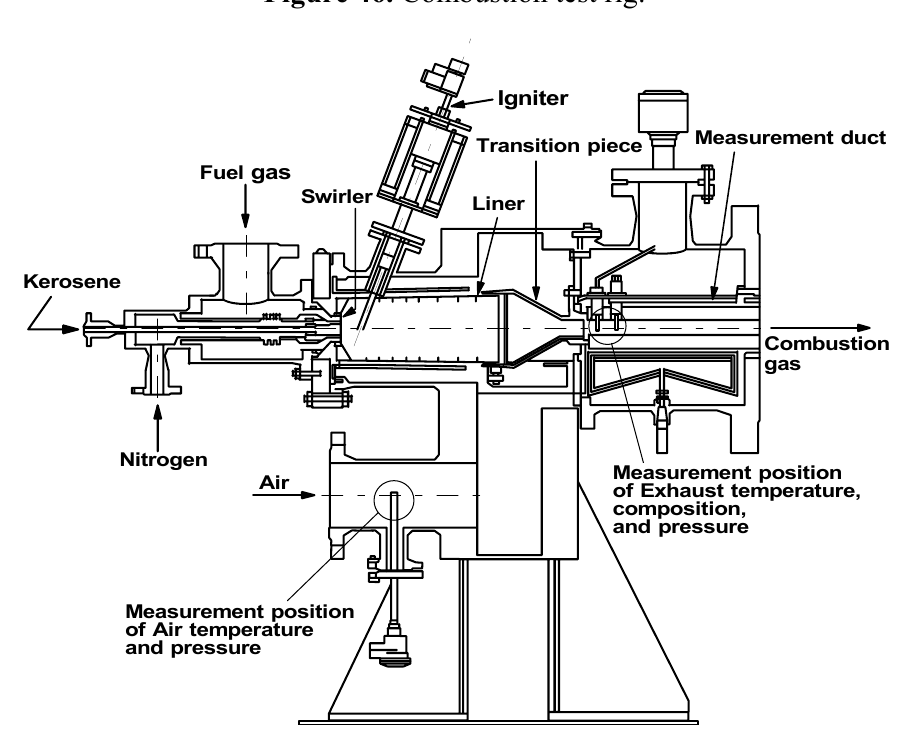
Figure 46. Combustion test